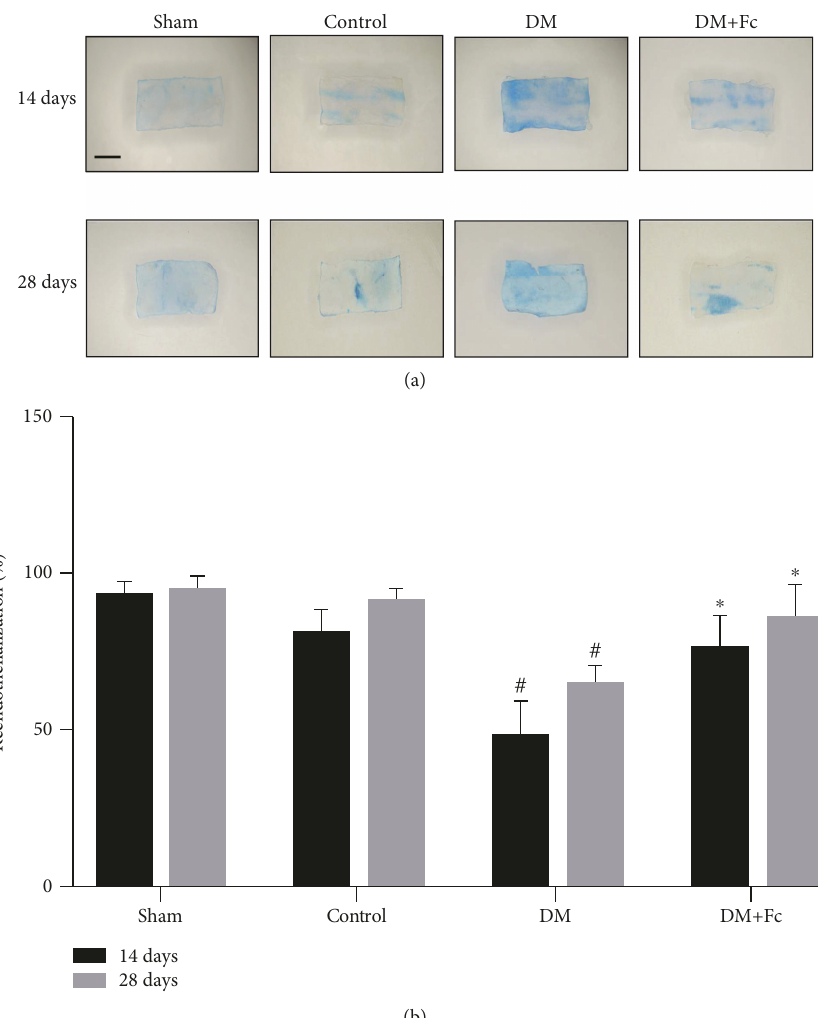
Figure 2: E ff ects of notoginsenoside Fc (Fc) on reendothelialization following carotid artery injury. Reendothelialization was quanti fi ed in Evans blue-stained carotid arteries at 14 and 28 days after vascular wire injury. (a) Blue staining indicates endothelial denudation. (b) The reendothelialization rates in the rats across treatment groups were analyzed statistically. The images are at 10x magni fi cation. Scale bar = 1 mm . Data are shown as the mean ± standard deviation. # P < 0 05 and ## P < 0 01 vs. the control group; ∗ P < 0 05 vs. the diabetes mellitus (DM) group. n = 6